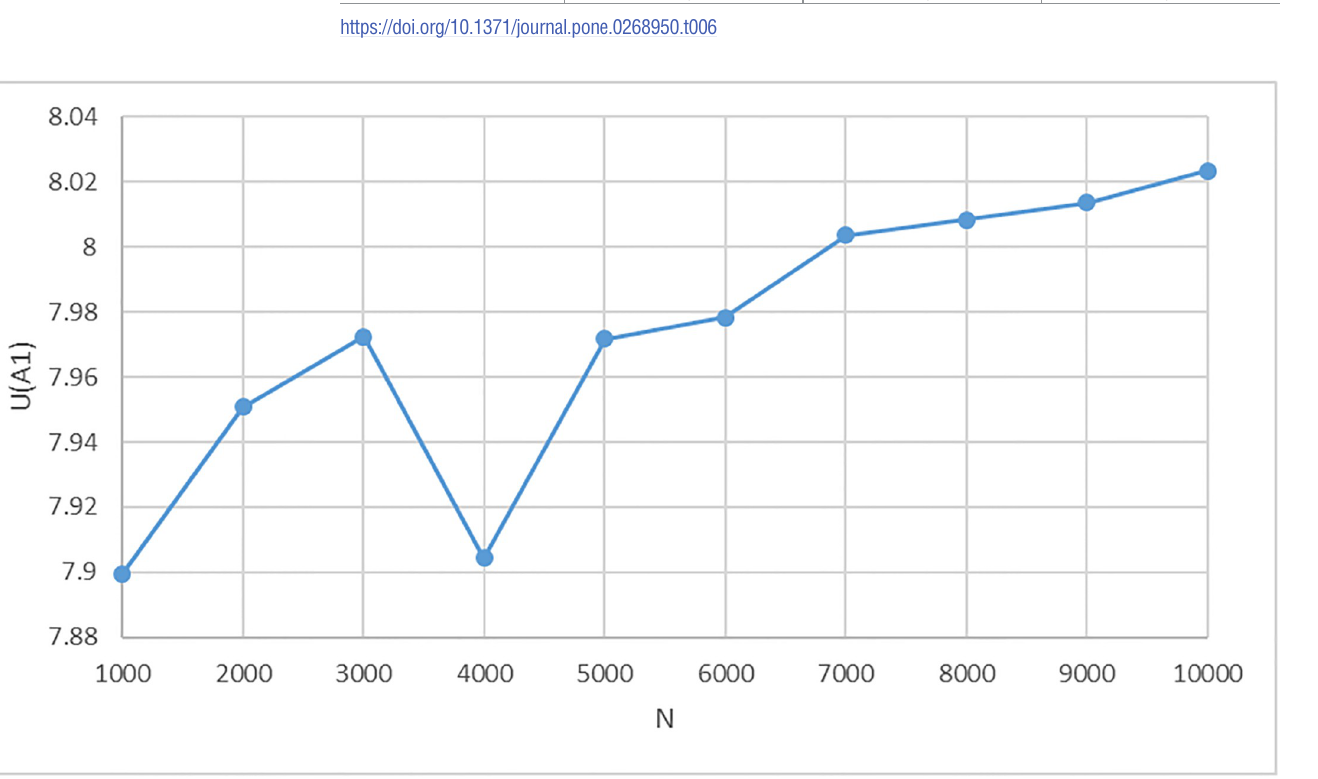
Fig 4. The dependence of U ( A 1 ) mean values on N